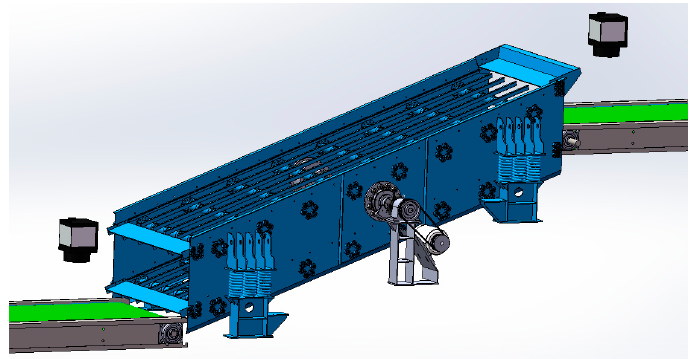
Figure 1. The online image-detection system for coal dry screening.